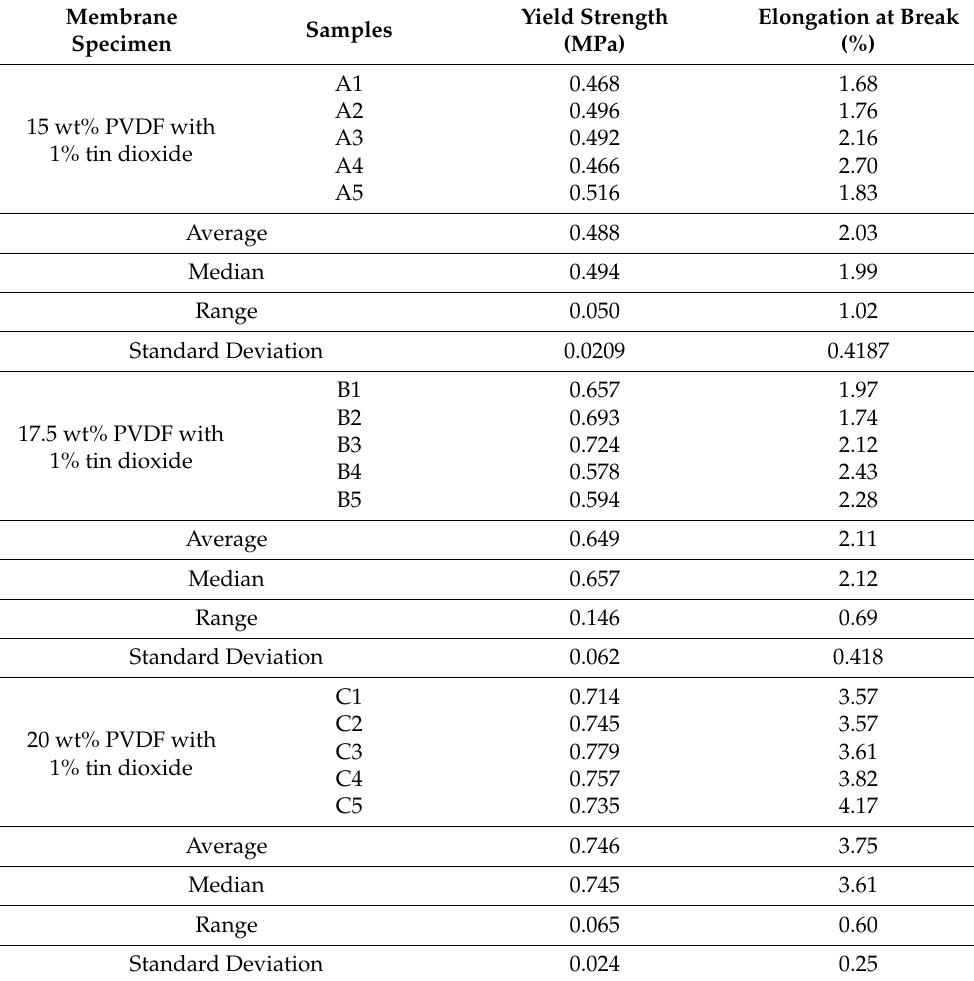
Table 1. Mechanical properties of the PVDF and tin dioxide